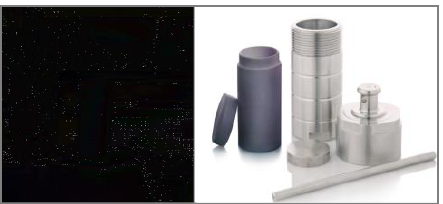
Figure 2. The cylindrical steel reactor (Techinstro) internally coated with PTFE.